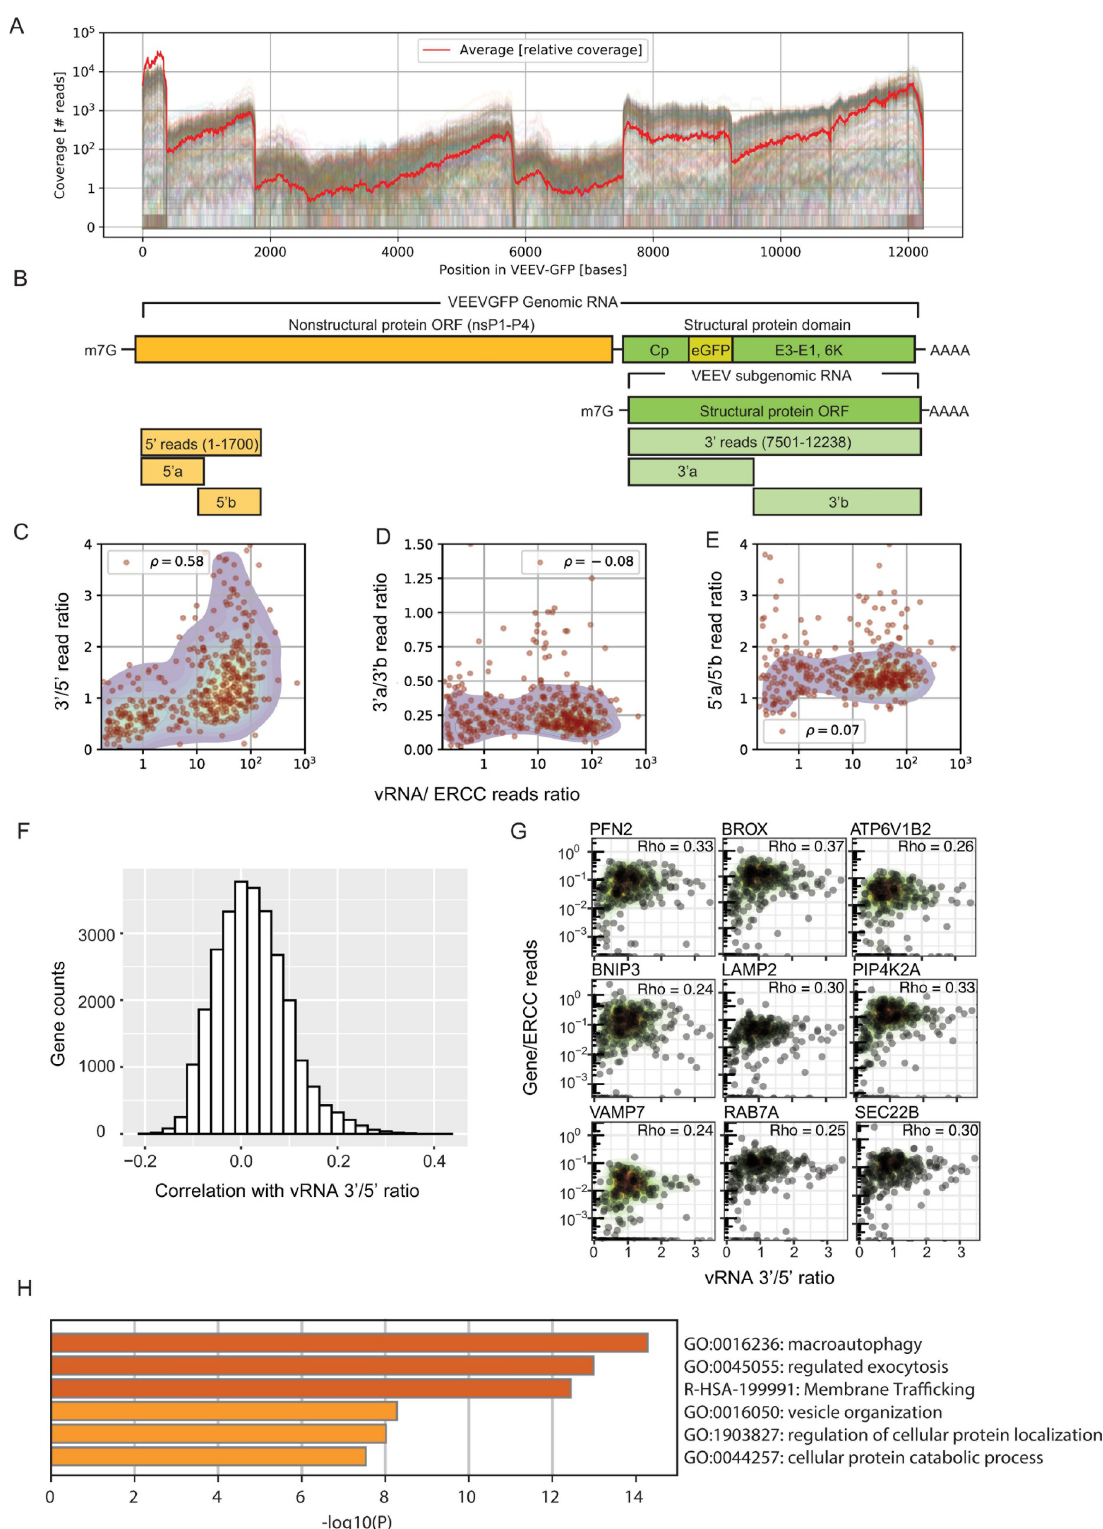
Fig 4. The expression of genes involved in intracellular membrane trafficking correlates with the ratio of 3’ to 5’ vRNA reads. (A) Coverage of viral reads over the entire VEEV-TC-83 genome. Each line is a cell, and the red line is a scaled average across all cells.